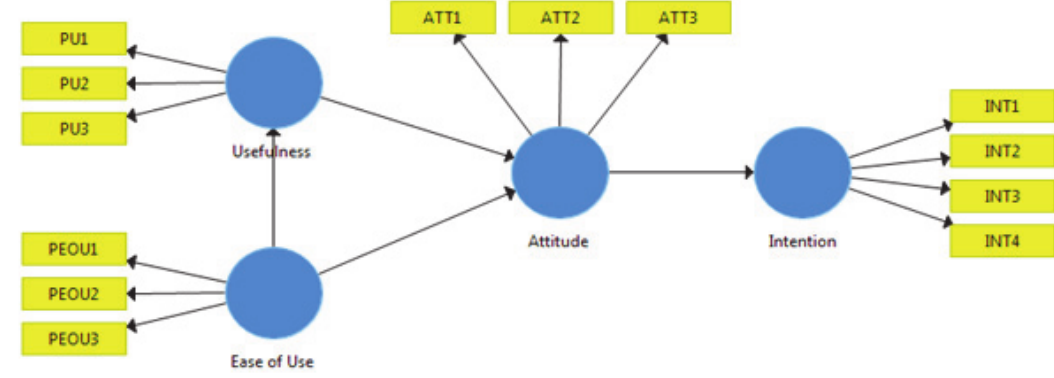
Fig. 1. Theoretical